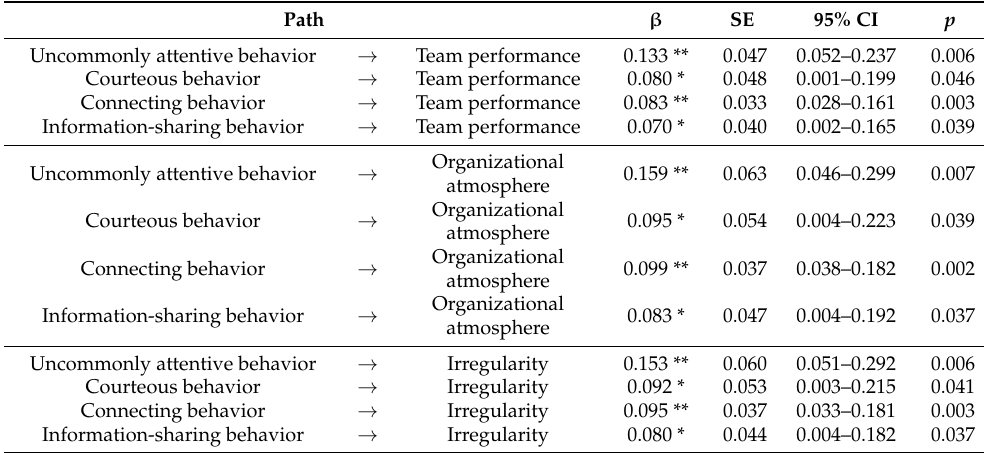
Table 8. Results from testing indirect effects.